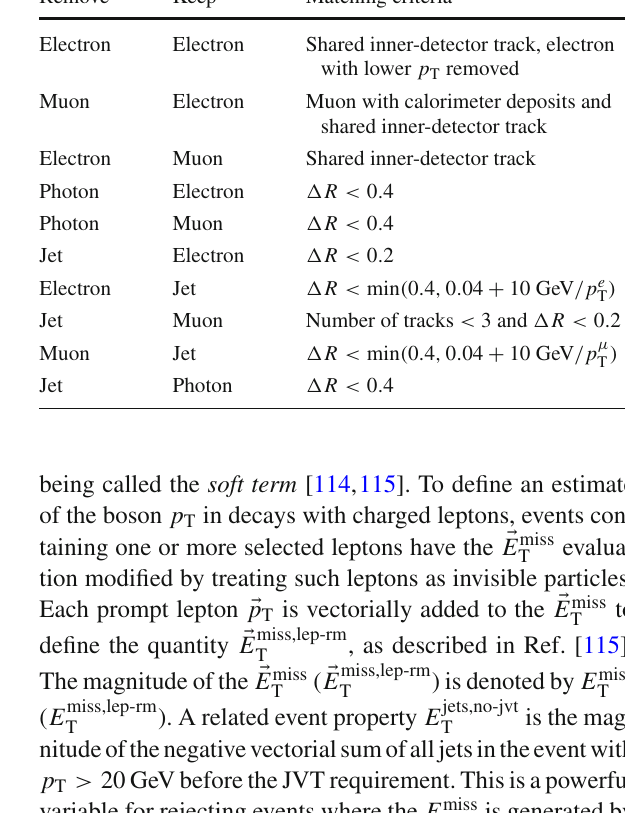
Table 2 Overview of the overlap removal between objects and the corresponding matching criteria, listed according to decreasing priority Remove